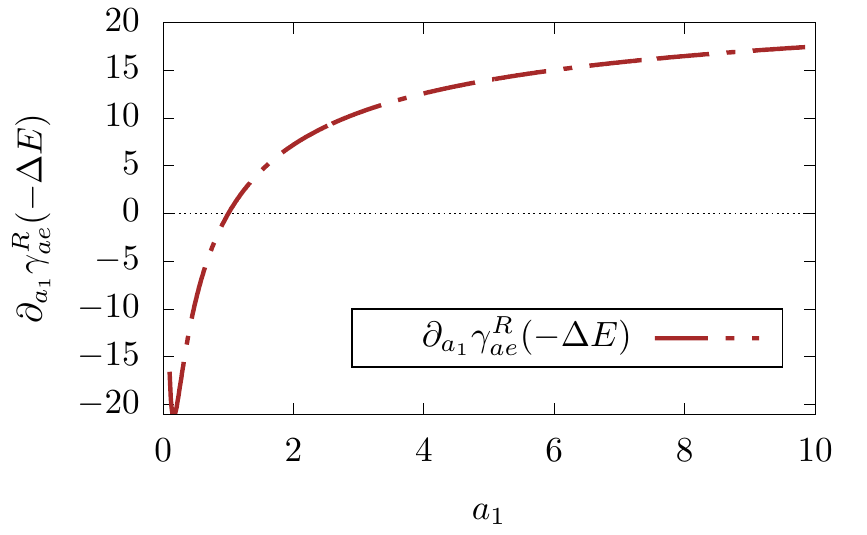
Figure 16 . The quantity ∂ a γ R ( − ∆ E ) corresponding to the transition from the anti-symmetric ae 1 state to the collective excited state is plotted with respect to varying a 1 for accelerated atoms in thermal background with Rindler modes. This quantity is positive for values above a 1 = 1 , like the ∂ a γ R (∆ E ) previously depicted in figure 14. ae 1